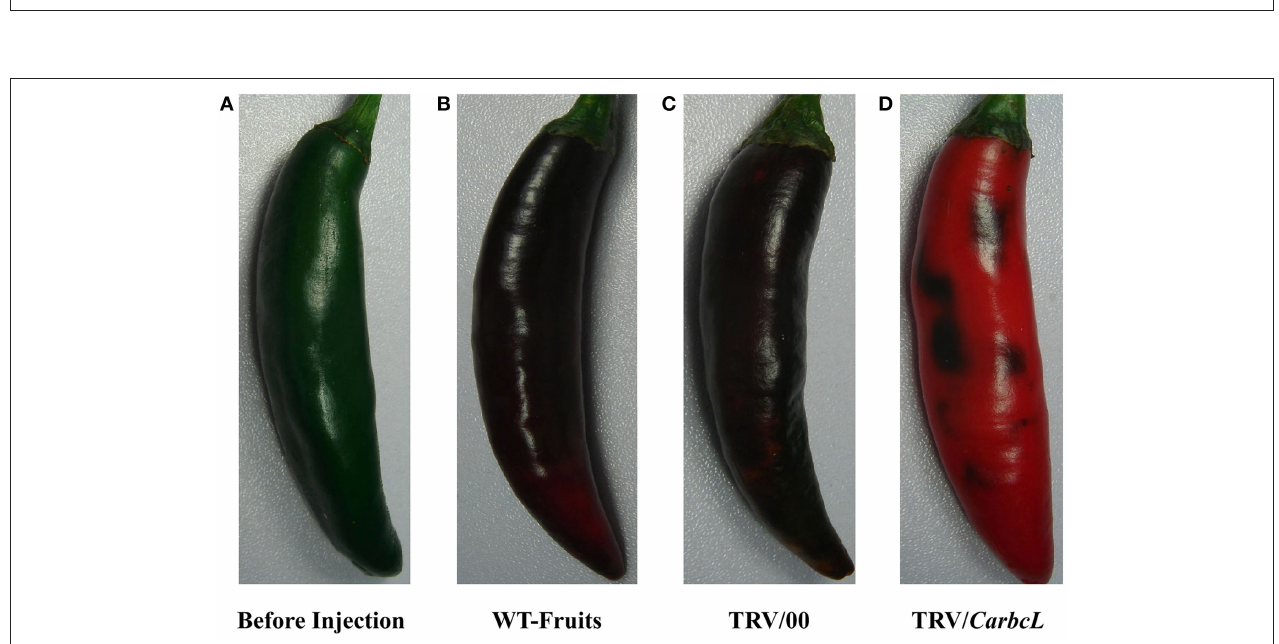
FIGURE 4 | Phenotypes of plants after CarbcL gene silencing. (A) Before injection, the color of fruits before the sample was treated; (B) WT-Fruits, the color of fruits in the control group after 10 days; (C) TRV/00, the color of fruits in the empty vector group after 10 days; (D) TRV/ CarbcL , the color of fruits in the treatment group (fruits were injected TRV/ CarbcL ) after 10 days of